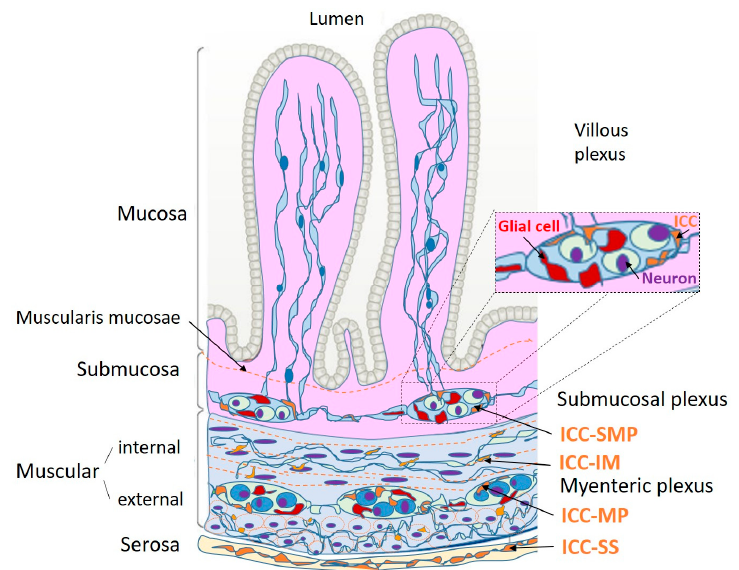
Figure 1. Organization of interstitial cells of Cajal (ICC) at submucosal and myenteric plexuses in the digestive tube. There are three principal cells represented in plexuses: neurons, glial cells, and the ICCs. Some prolongations end into mucosa. ICC-SMP: ICC of submucosal plexus; ICC-MP: ICC of myenteric plexus; ICC-IM: ICC intramuscular at internal and external muscular; ICC-SS: ICC of serosa. Modified from [5].